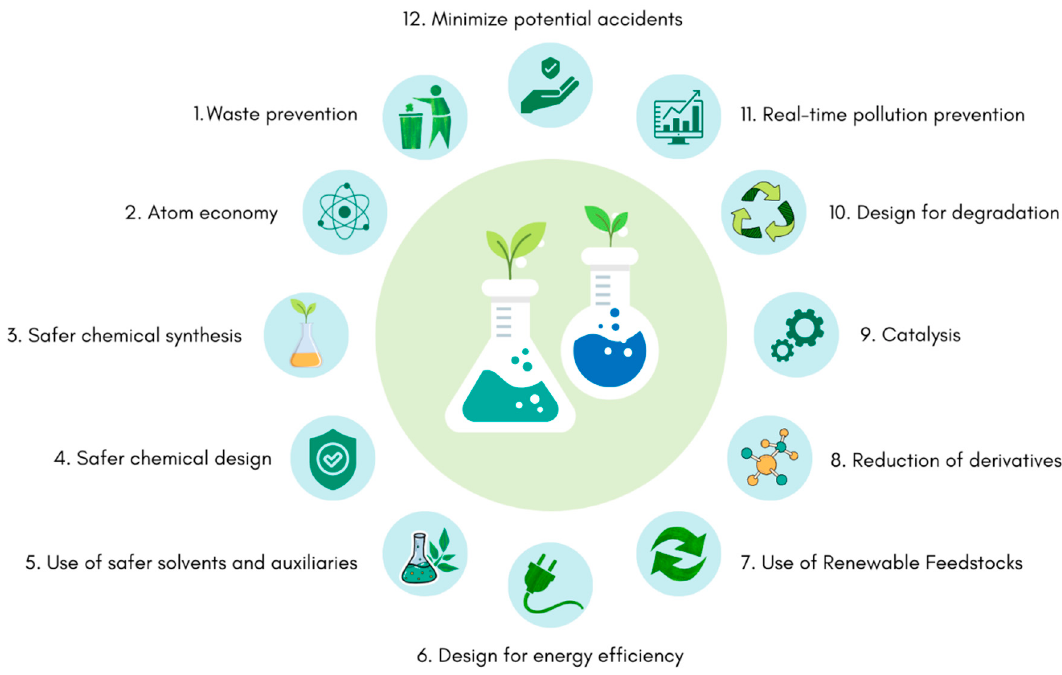
Figure 2. Schematic representation of the twelve principles of green chemistry. Figure adapted from [27] and created in Canva.com (accessed on 24 January 2023).